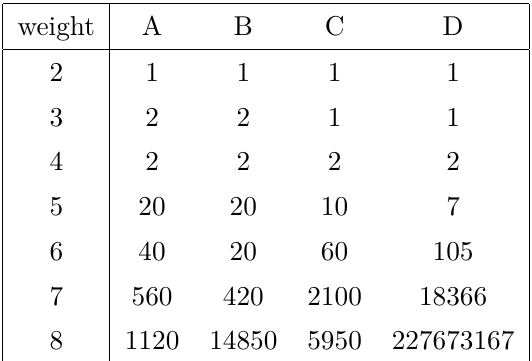
at weight p in the four ijα